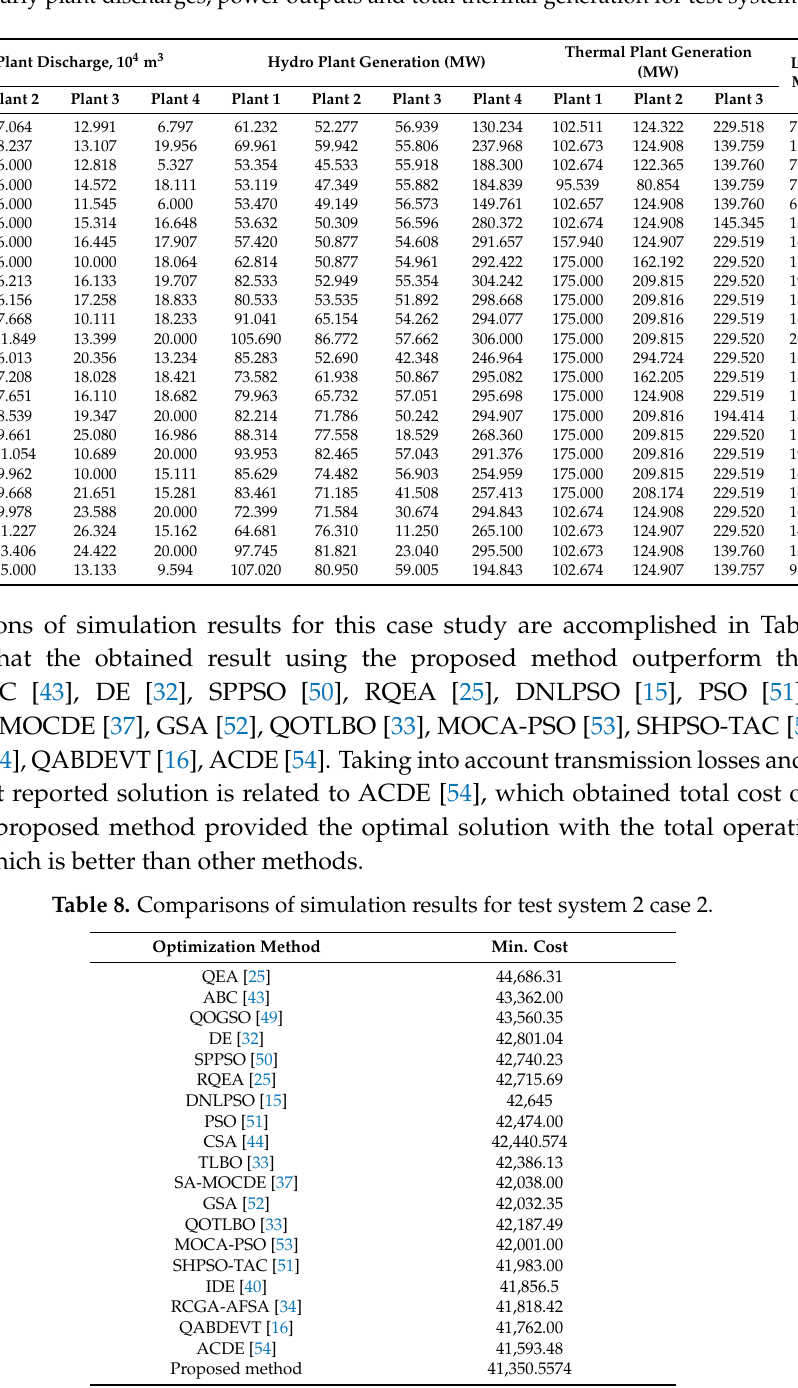
Table 7. Hourly plant discharges, power outputs and total thermal generation for test system 2 case 2.